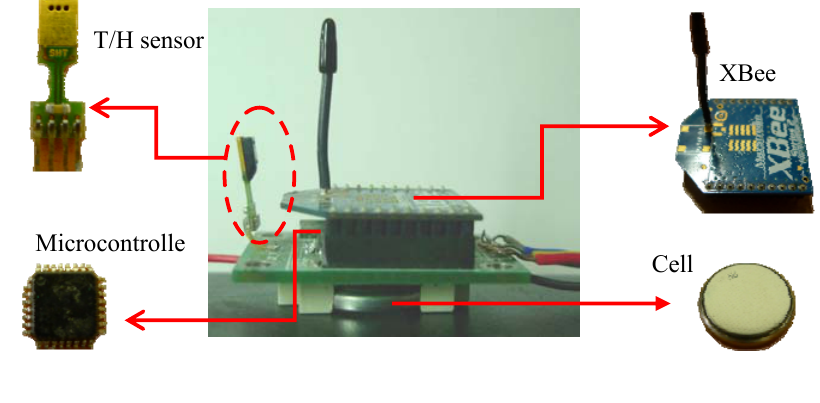
Figure 2. STHIM transmitter actual